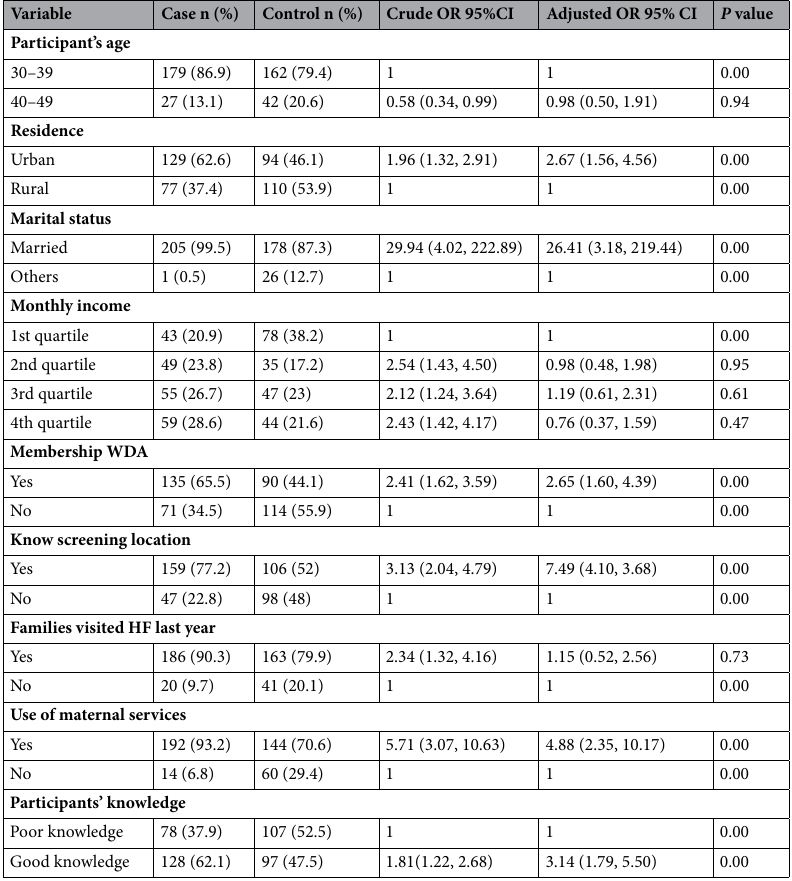
Table 4. Multivariable binary logistic regression predicting cervical cancer screening utilization among participants in Hadiya and Kembata Tembaro zones, SNNPRG, Ethiopia, October to November